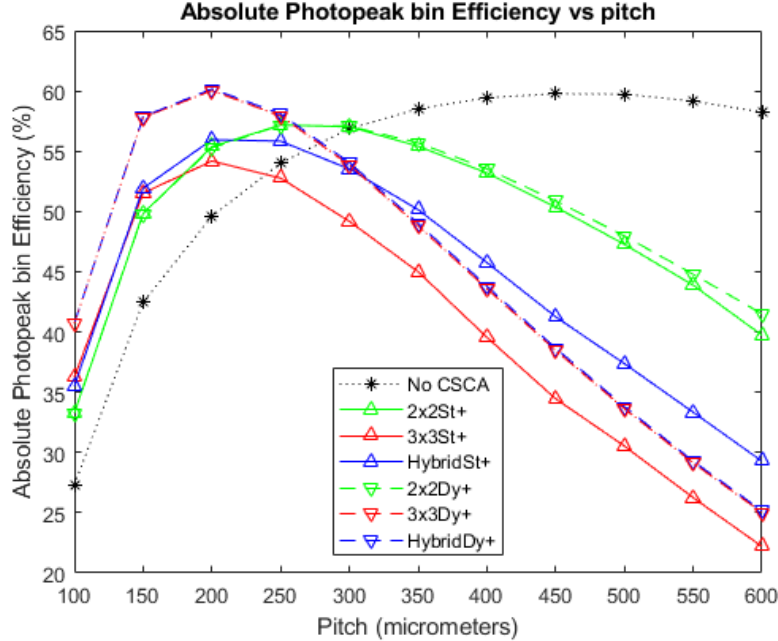
Figure 9. A plot of APE versus pixel pitch at an incident photon flux of 10 7 photons mm −2 s −1 . The dynamic Hybrid and dynamic 3 × 3 CSCAs perform indistinguishably according to this metric, resulting in significant overlap. Similarly, the 2 × 2 dynamic and static CSCAs overlap at low pitches (below ~350 µm) but begin to become distinguishable at the higher pitches considered here. The case where no CSCA is applied is also shown as a reference.